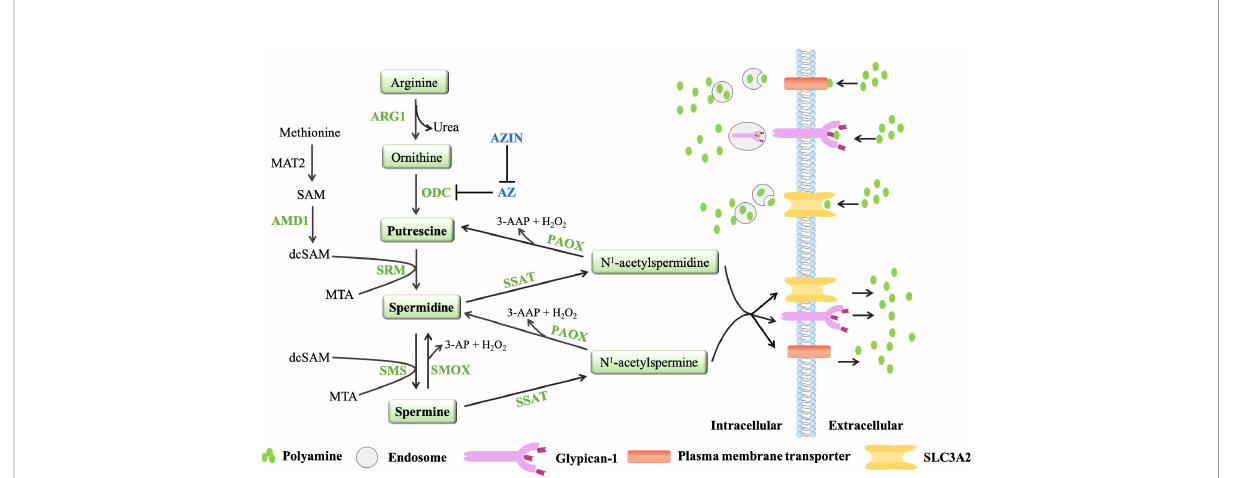
FIGURE 2 The polyamine metabolic pathway and transport way. Polyamine biosynthesis involves the conversion of ornithine to putrescine by ornithine decarboxylase (ODC), followed by the formation of spermidine via spermidine synthase (SRM) and decarboxylated s-adenosylmethionine (dcSAM, formed by AMD1). The aminopropyl fragment required for putrescine to produce spermidine was provided by dcSAM. In a similar manner, spermine is produced from the conversion of spermidine by spermine synthase (SMS) and AMD1. The polyamine catabolism process occurs through the action of amine oxidase, mainly polyamine oxidase (PAOX) and spermine oxidase (SMOX). PAOX and SMOX can generate a large amount of reactive oxygen species (ROS) during the process of decomposing polyamines, causing oxidative damage. Currently, three models of polyamine transport systems have been proposed. Although the molecules involved in the polyamine transport system have not been fully recognized, it is known that the polyamine transport system is energy dependent and substrate selective. ODC antienzymes (AZs) and antizyme inhibitors (AZINs) also play important roles in polyamine transport. ODC monomers have a higher af fi nity for AZs. When the intracellular polyamine concentration is high, AZs binds to ODC monomers, preventing ODC activity and promoting